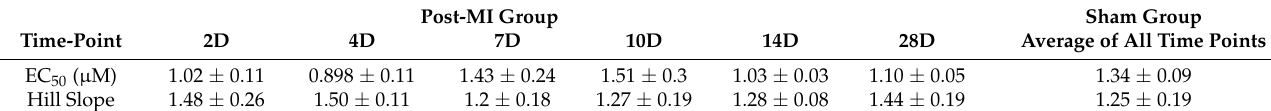
Table 1. EC 50 and Hill slopes of post ‐ MI and sham groups.